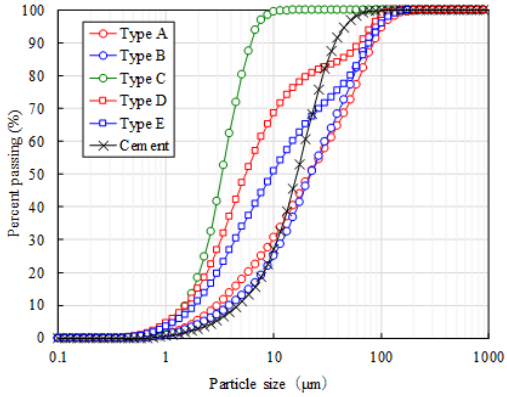
Figure 2. Grain size accumulation curve of crushed sand.